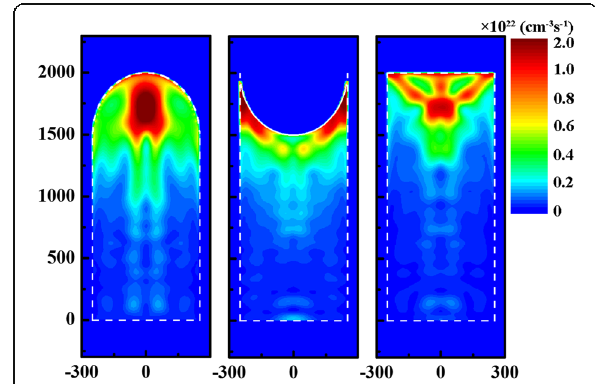
Fig. 4 Spatial distribution of the photo-generated carrier generation rate at AM 1.5G illumination for the arrays ( H = 2000 nm and D = 500 nm) top-modified by (left) hemiellipsoids ( h = 500 nm) and (middle) inverted hemiellipsoids ( h = 500 nm). The generation rate (right) in the pure NW array of H = 2000 nm and D = 500 nm is